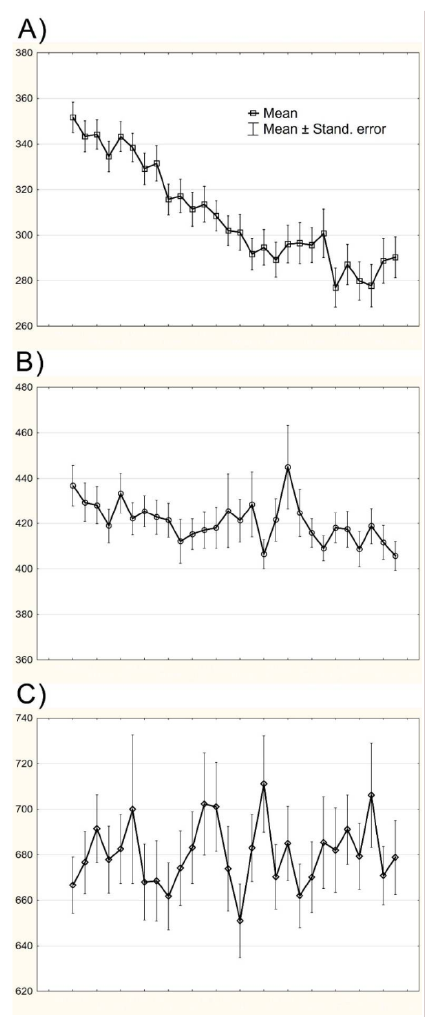
Figure 2. The range of trial-to-trial variability for FT-uncorrected series of consecutive RTs in ( A ) task T 1, ( B ), T 2 and ( C ) T 3 performed by the whole analyzed sample. Figure shows averaged mRTs and the range of mean ± standard error of the mean. The curve containing RTs for T 1 ( A ) task is descending consistently with statistical analysis confirming significant, gradual performance acceleration. On the other hand, fluctuations in successive RTs are very slight. The level of RTs variability in tasks T 2 and T 3 is stable throughout the performance and it seems evident, that fluctuations between consecutive RTs are most pronounced in T 3 task ( C ). Significant acceleration of performance speed in T 1, leading to the substantial difference between RTs from the initial and final phases of execution, might have caused that parametric measures of variability (iSD and CoV) showed some similarities in this respect between the three tasks, despite a clear difference in the range of fluctuations among successive RTs, especially in tasks T 1 and T 3. All data are presented in milliseconds scale and concerns sets of RT after initial cleaning for the extreme outliers. Axis x—a set of consecutive RTs, axis y—time in